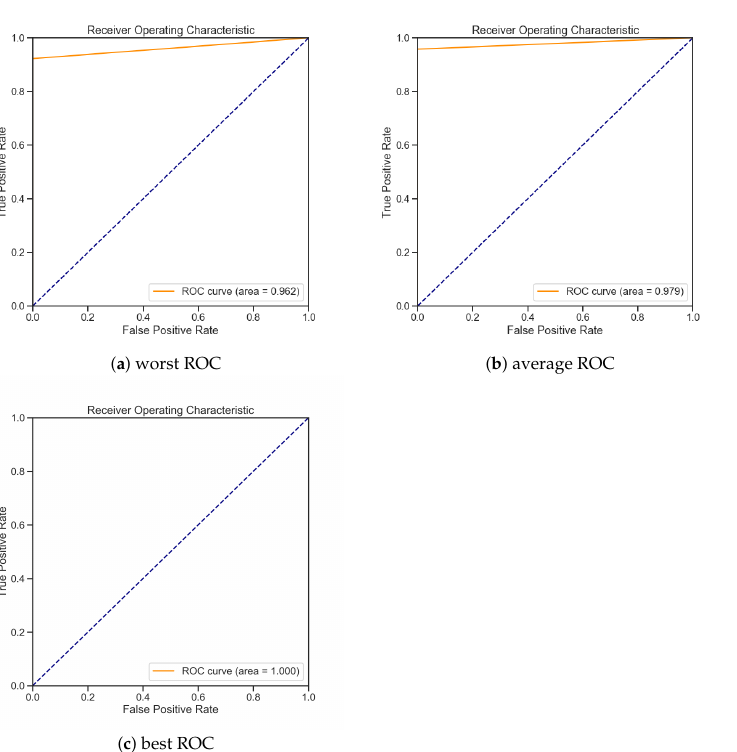
Figure 13. ROC, worst, average and best cases.